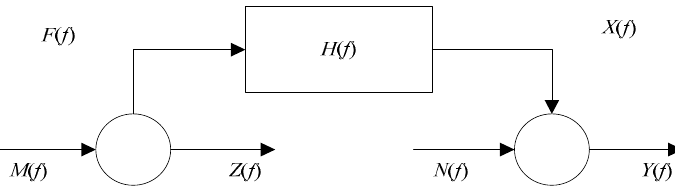
Figure 5. Prediction process when input and output contain noise.